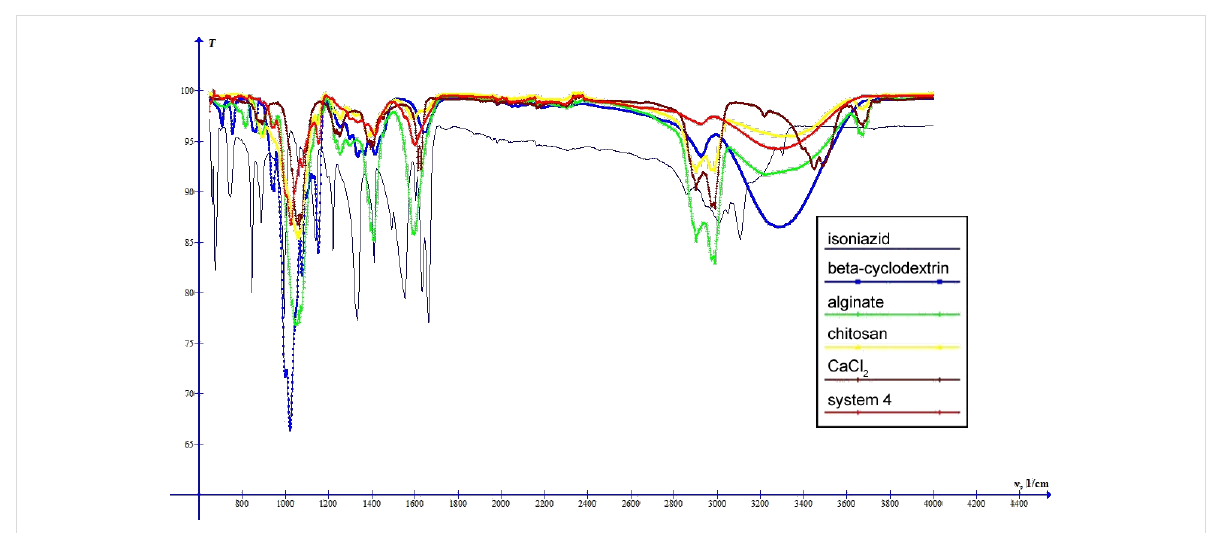
Figure 10: IR spectra of INH, β -cyclodextrin, sodium alginate, chitosan, calcium chloride and system